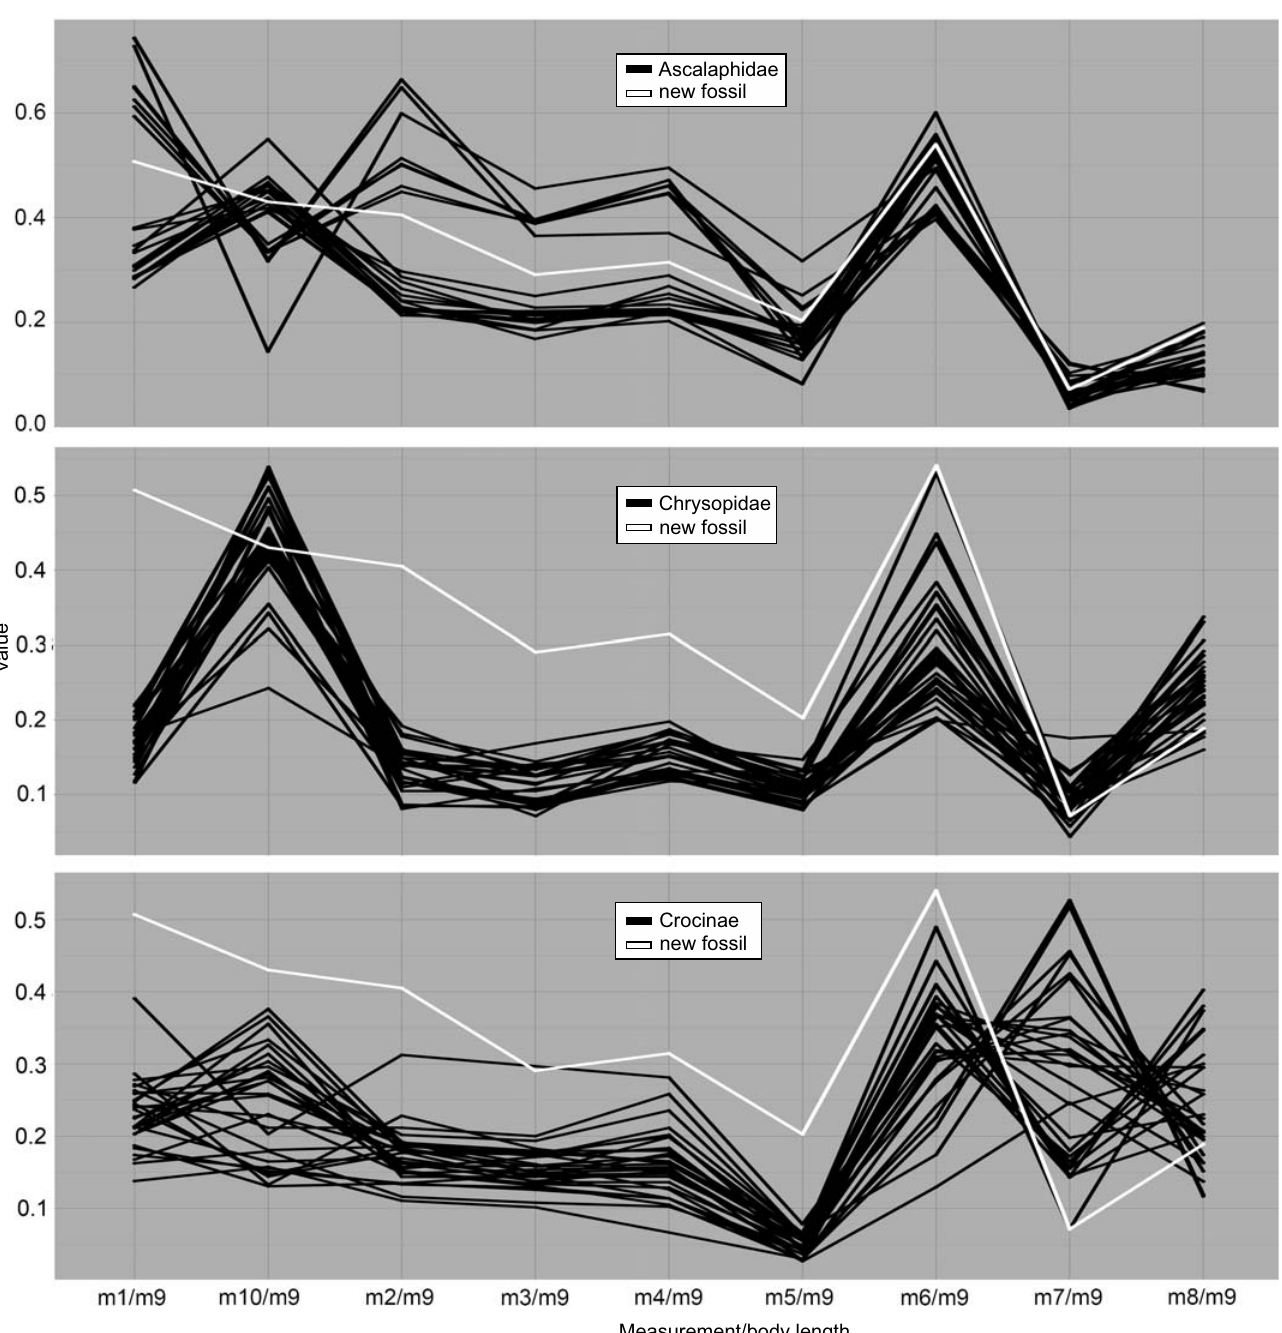
Fig. 5. Parallel coordinates plot for larvae of Ascalaphidae (owl flies), Chrysopidae (green lacewings), and Crocinae (thread-winged lacewings). White line represents MfN MB.I